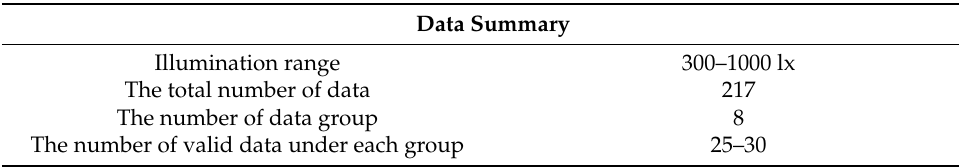
Table 2. Illumination data